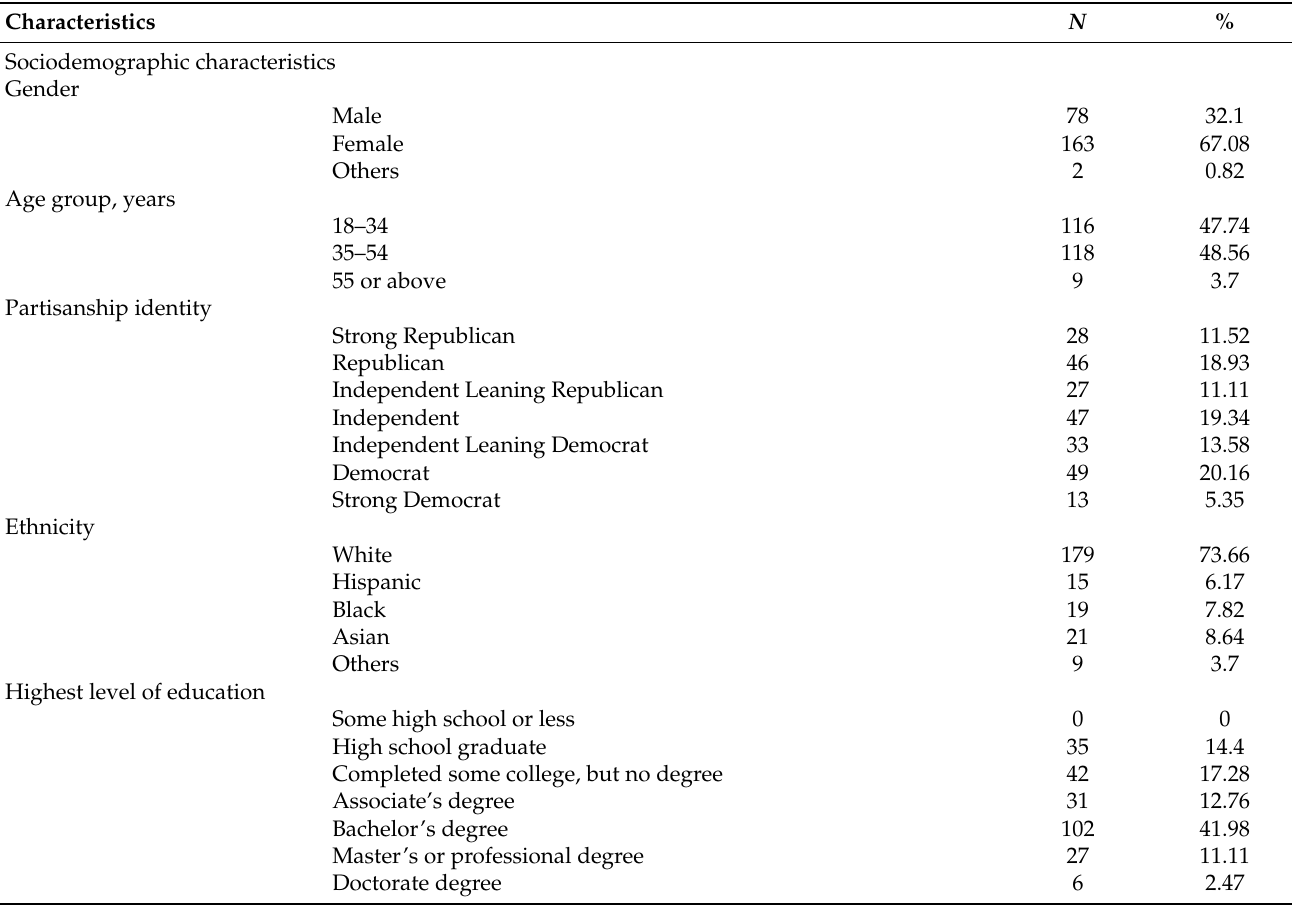
Table 3. Background characteristics of the participants ( n =